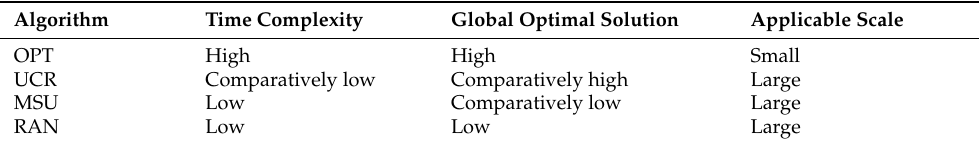
Table 4. Algorithm Table 4. Algorithm Comparison.